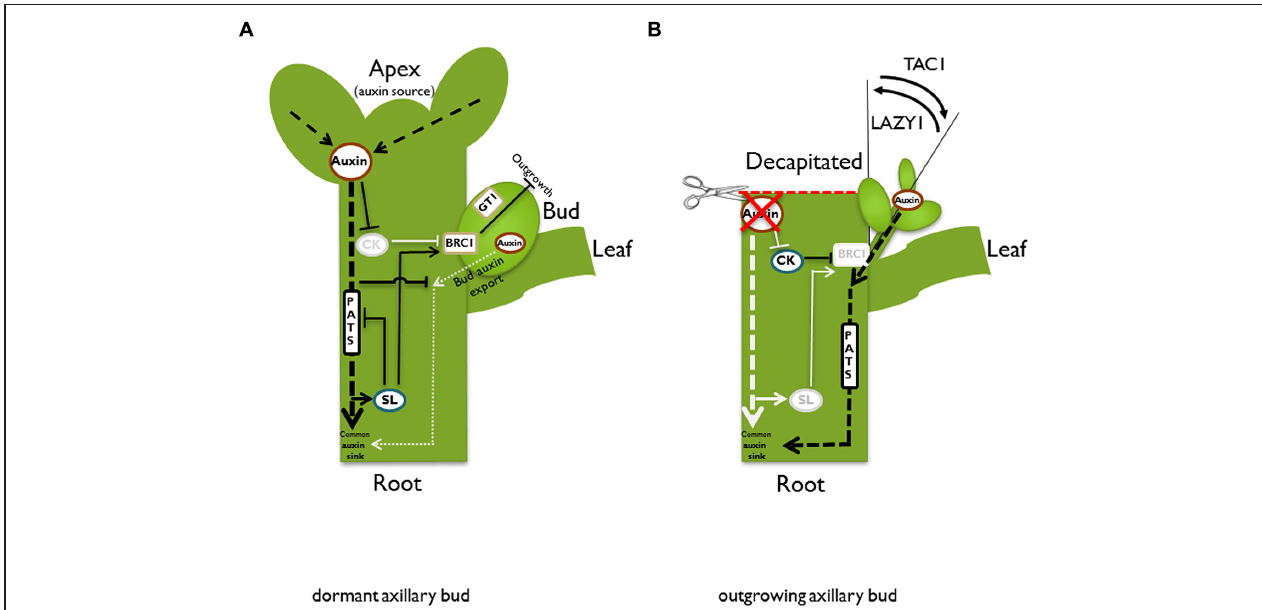
FIGURE 2 | Schematic illustration of different pathways and models in the control of bud outgrowth. In an intact plant (A) , the apex is a strong auxin source. Auxin is transported basipetally in the polar auxin transport stream (PATS). According to the second messenger model, auxin promotes strigolactone (SL) and represses cytokinin (CK) biosynthesis, respectively. Both hormones have adverse effects on bud outgrowth, most likely acting via the transcription factor BRANCHED1 / TEOSINTE BRANCHED1 ( BRC1 / TB1 ). Auxin indirectly promotes BRC1 / TB1 expression, which suppresses bud